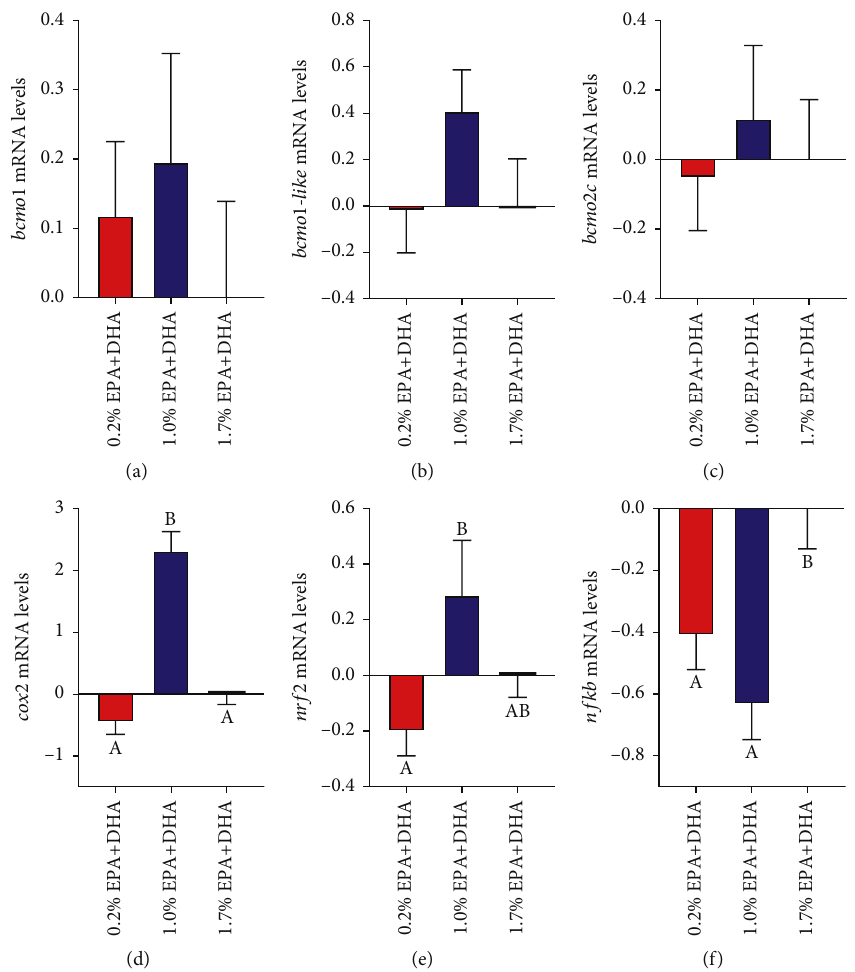
Figure 4: Expression of the genes bcmo1 (a), bcmo2c (b), bcmo1-like (c), cyclooxygenase 2 (d) NF-E2-related factor 2 (e), nuclear factor- kappa B (f) in the mid-intestine in salmon fed diets containing 1.7% EPA+DHA (control), 1% EPA+DHA, and 0.2% EPA+DHA (low) from 400 – 3500g (period 2). Data from fi sh fed di ff erent diets in period 1 (40 – 400 g) are pooled. Values aremeans per treatment ð dietperiod2 Þ ± SEM . Means labelled with common letters are not signi fi cantly di ff erent ( P < 0.05